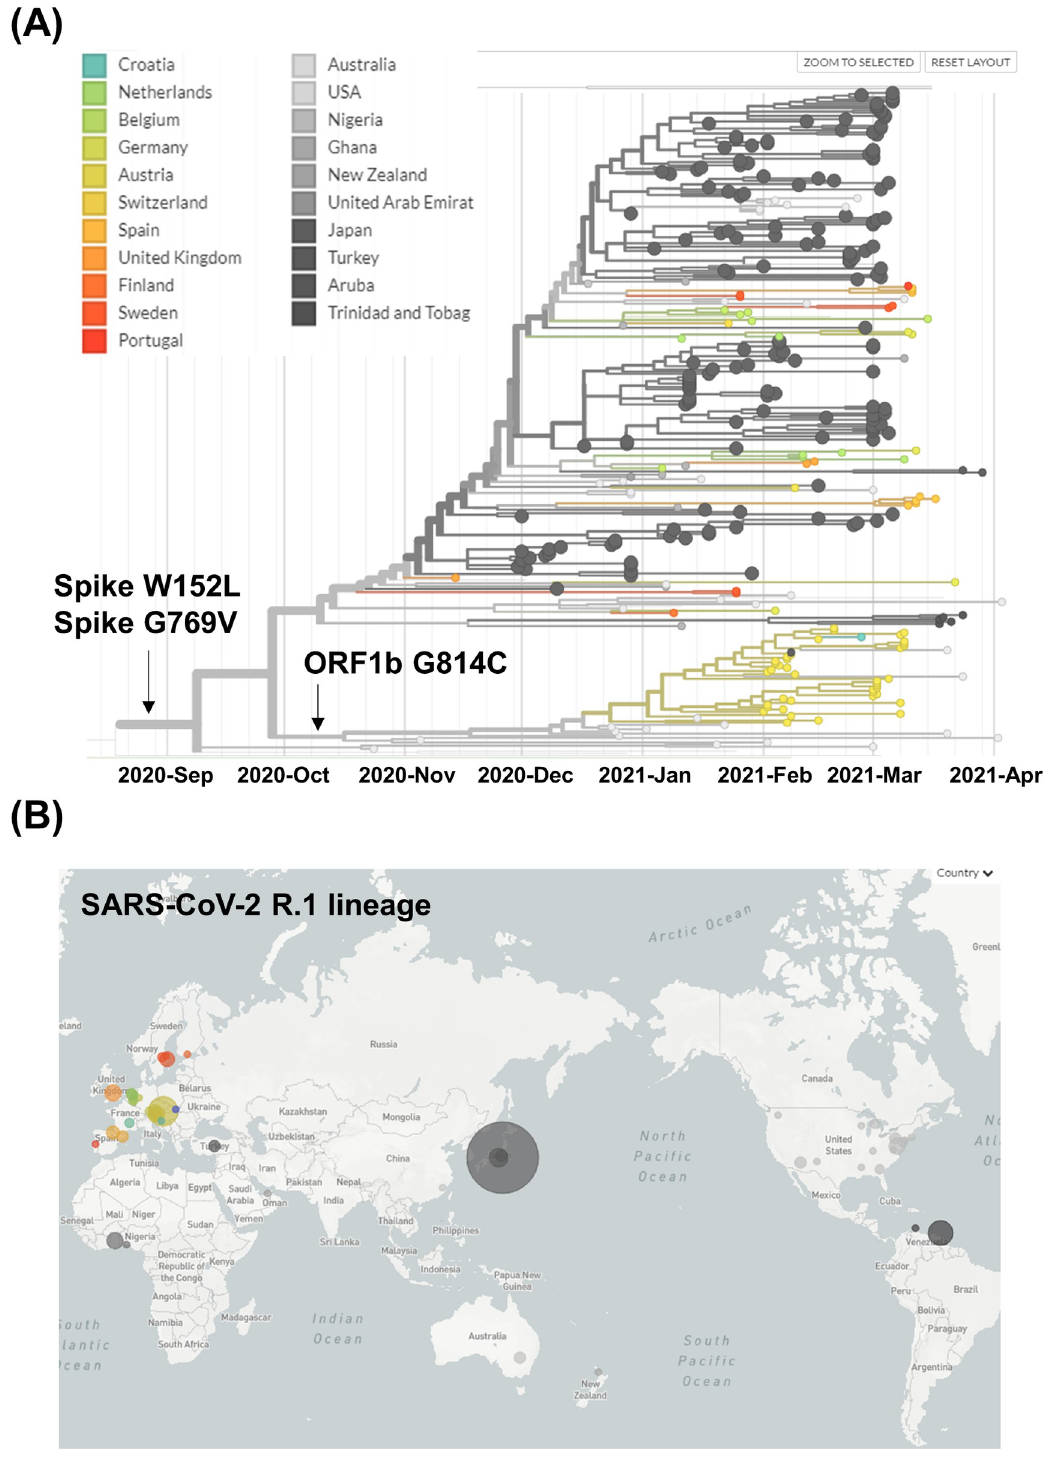
Fig 3. Phylogenetic tree of R.1 lineage SARS-CoV-2. (A) Global data on the SARS-CoV-2 R.1 lineage prevalence over time. The R.1 lineage acquired its spike W152L and G769V mutations at the root. The sublineage harbors an ORF1b G814C mutation. (B) Geographic distribution of the SARS-CoV-2 R.1 lineage. World map showing the geographic distribution of SARS-CoV-2 R.1 lineage as of April 22, 2021. The size of the circle indicates the number of samples. Nextstrain, https://nextstrain.org, CC-BY-4.0